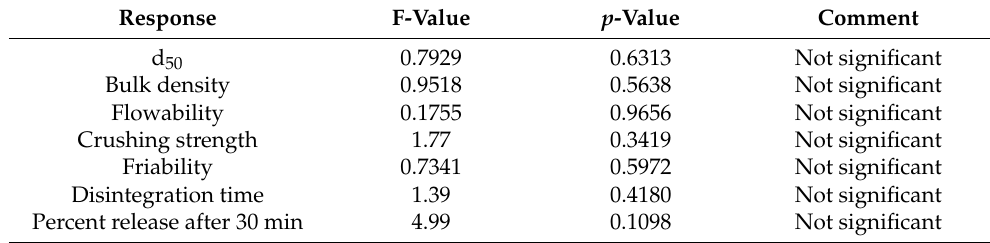
Table 9. Lack-of-fit test of measured